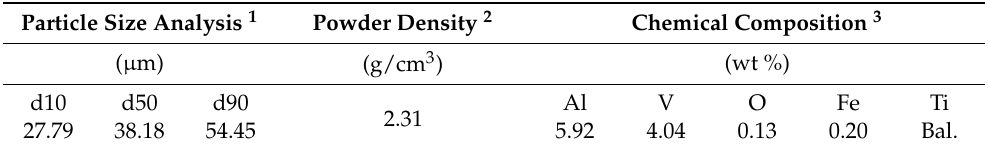
Table 1. SLM Ti64 powders properties and compositions. Data were gathered in accordance with the relevant international ASTM